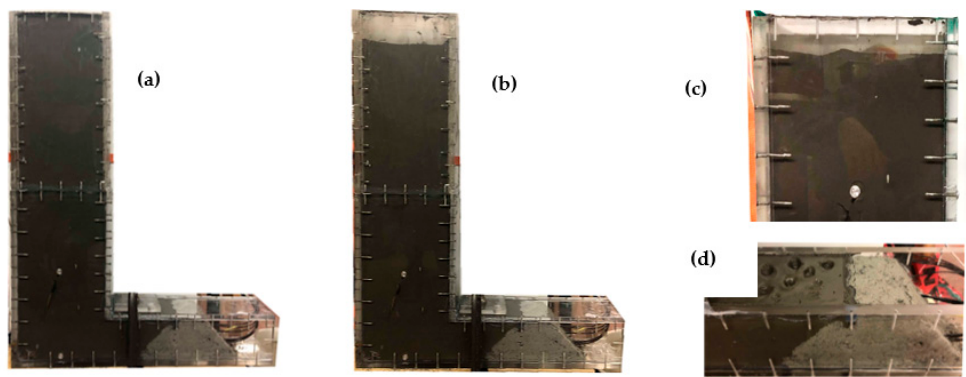
Figure 6. Uncemented backfill tests: ( a ) pouring of the second layer of backfill, ( b ) the model after self-weight consolidation of the second layer, ( c ) backfill bleeding water at the top of the filling chamber after each placement of the backfill, and ( d ) the state of the backfill near the barricade after four days (two layers were continuously poured, once every two days).